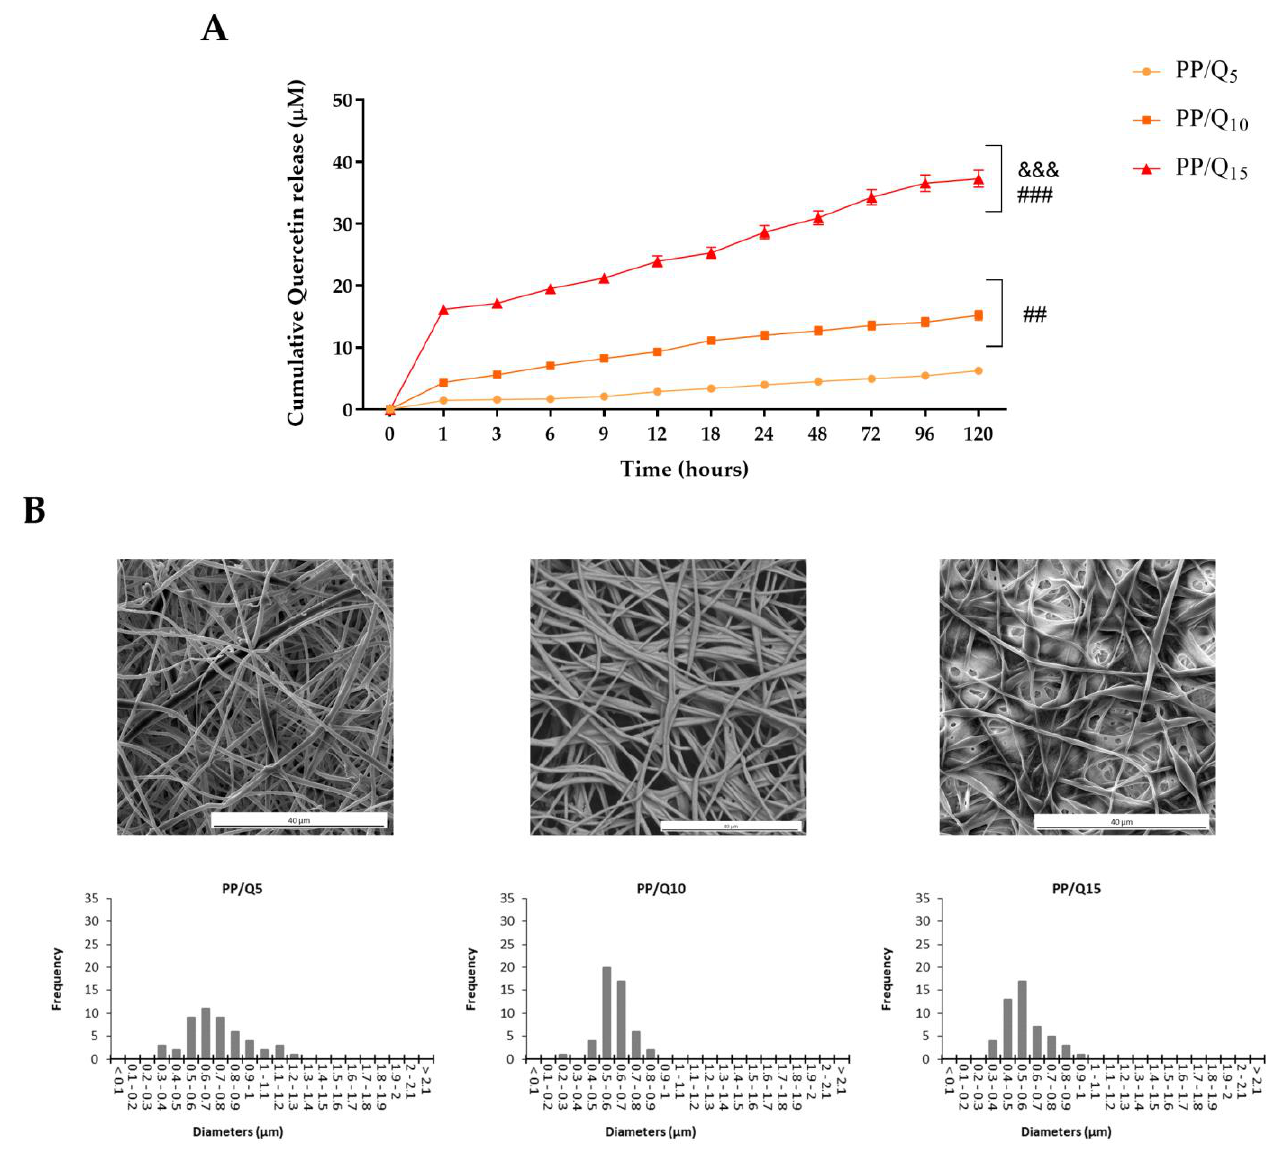
Figure 3. ( A ) Cumulative QUE release profiles at 37 °C of PP/Q 5 , PP/Q 10 and PP/Q 15 . All samples were incubated for 120 h in SWF at pH 7.2. Six independent experiments were performed, and the results expressed as the mean of the values obtained (mean ± SD). Statistically significant variations: ## p < 0.01 and ### p < 0.001 versus PP/Q 5 , and &&& p < 0.001 versus PP/Q 5 and PP/Q 10 . ( B ). SEM micrographs of PP/Q 5 , PP/Q 10 , and PP/Q 15 fibers and corresponding diameter distribution after 6 hours immersion in SWF.